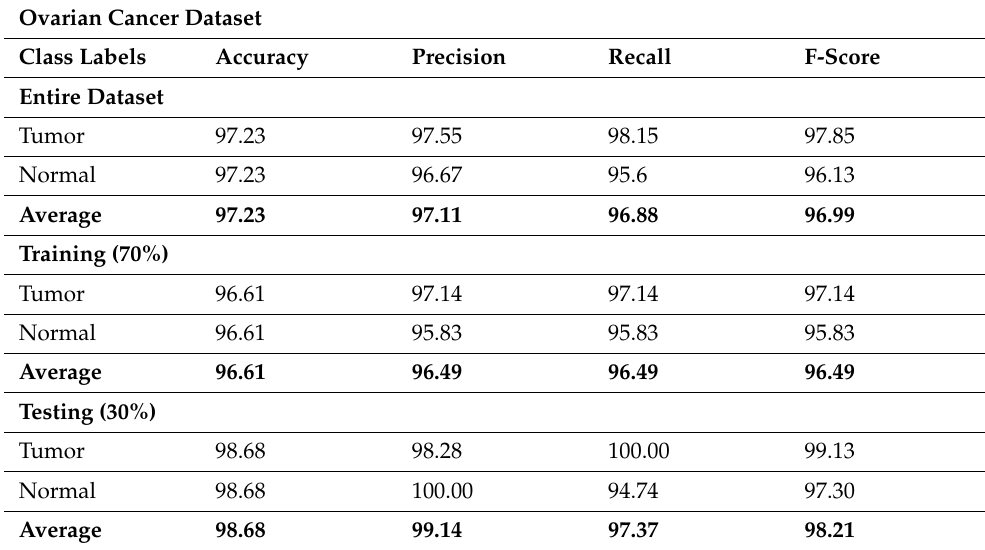
Table 4. Resulting analysis of RFODL-MGEC technique with various measures on ovarian cancer dataset.